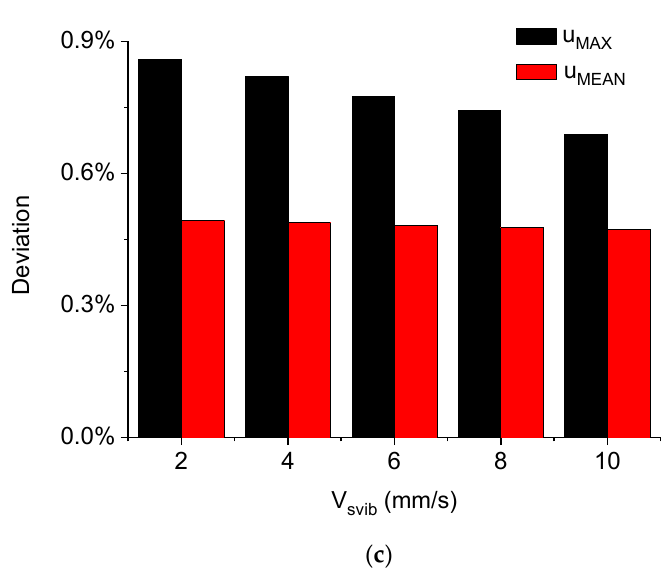
Figure 11. ( a ) Computed acoustic streaming velocity magnitude distribution along the r direction at the droplet-substrate interface in the droplet-ultrasonic substrate system under different V svib . ( b ) u MAX , u MEAN and SCD versus V svib in the droplet-ultrasonic substrate system. ( c ) Deviations of u MAX and u MEAN computed by the PM and RSM versus V svib in the droplet-ultrasonic substrate system.